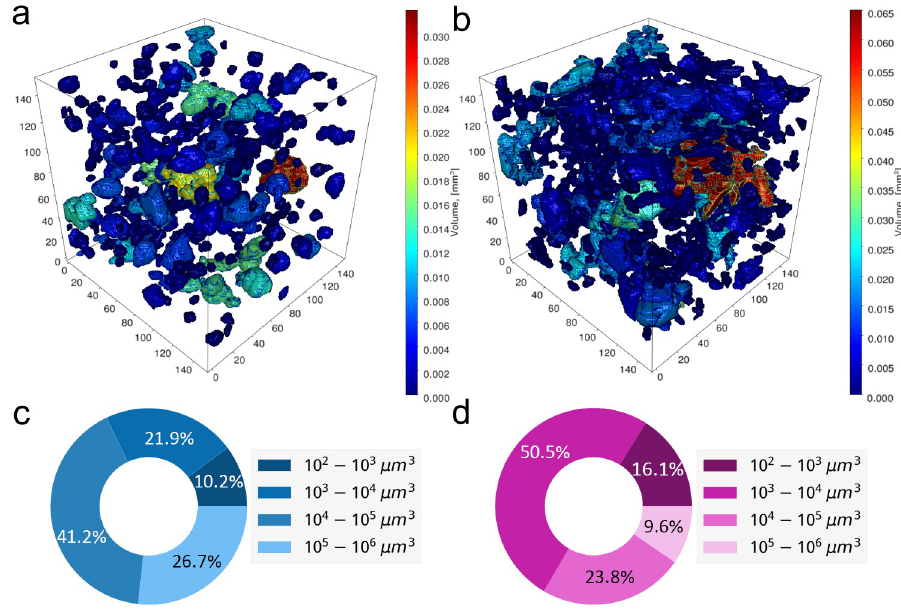
Fig 8. The analysis of hydrogels with BGSr (a) and α -TCP (b) particles and the measurements of particles distributions for each sample (c, d).